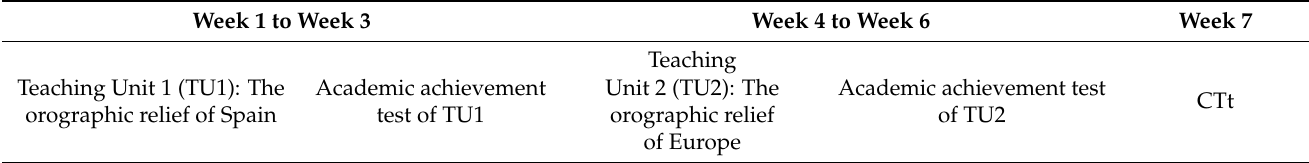
Table 1. Time sequence of methodological design.